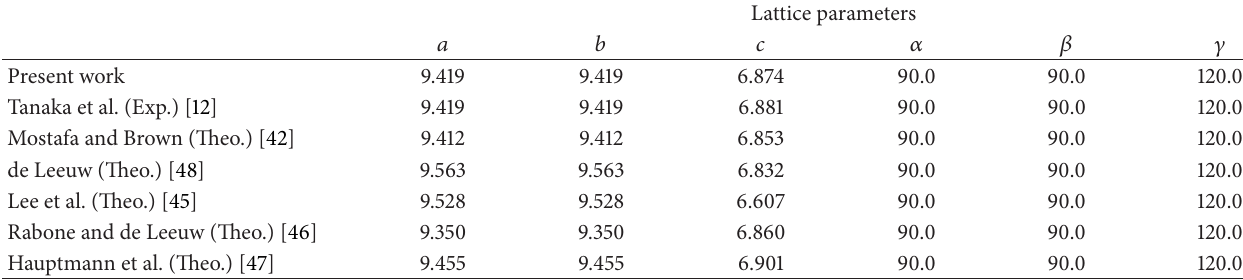
Table 2: Lattice parameters ( 𝑎, 𝑏,𝑐, 𝛼, 𝛽 , and 𝛾 ) calculated in the present work compared to experimental and other theorical works.